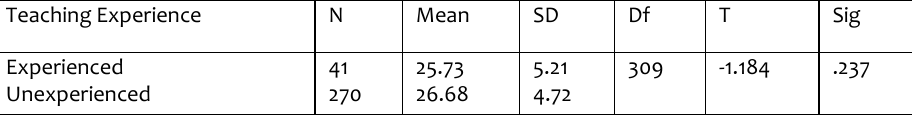
Table 4. Results of t-test for Comparison of the Trainees’ Rating Score on the Instructors’